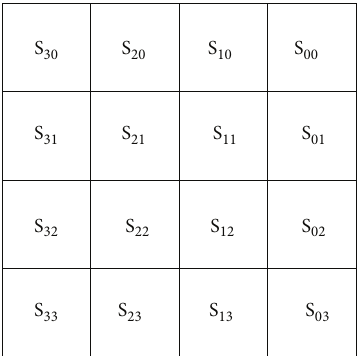
Figure 3: (a) Crypton and (b) mCrypton.